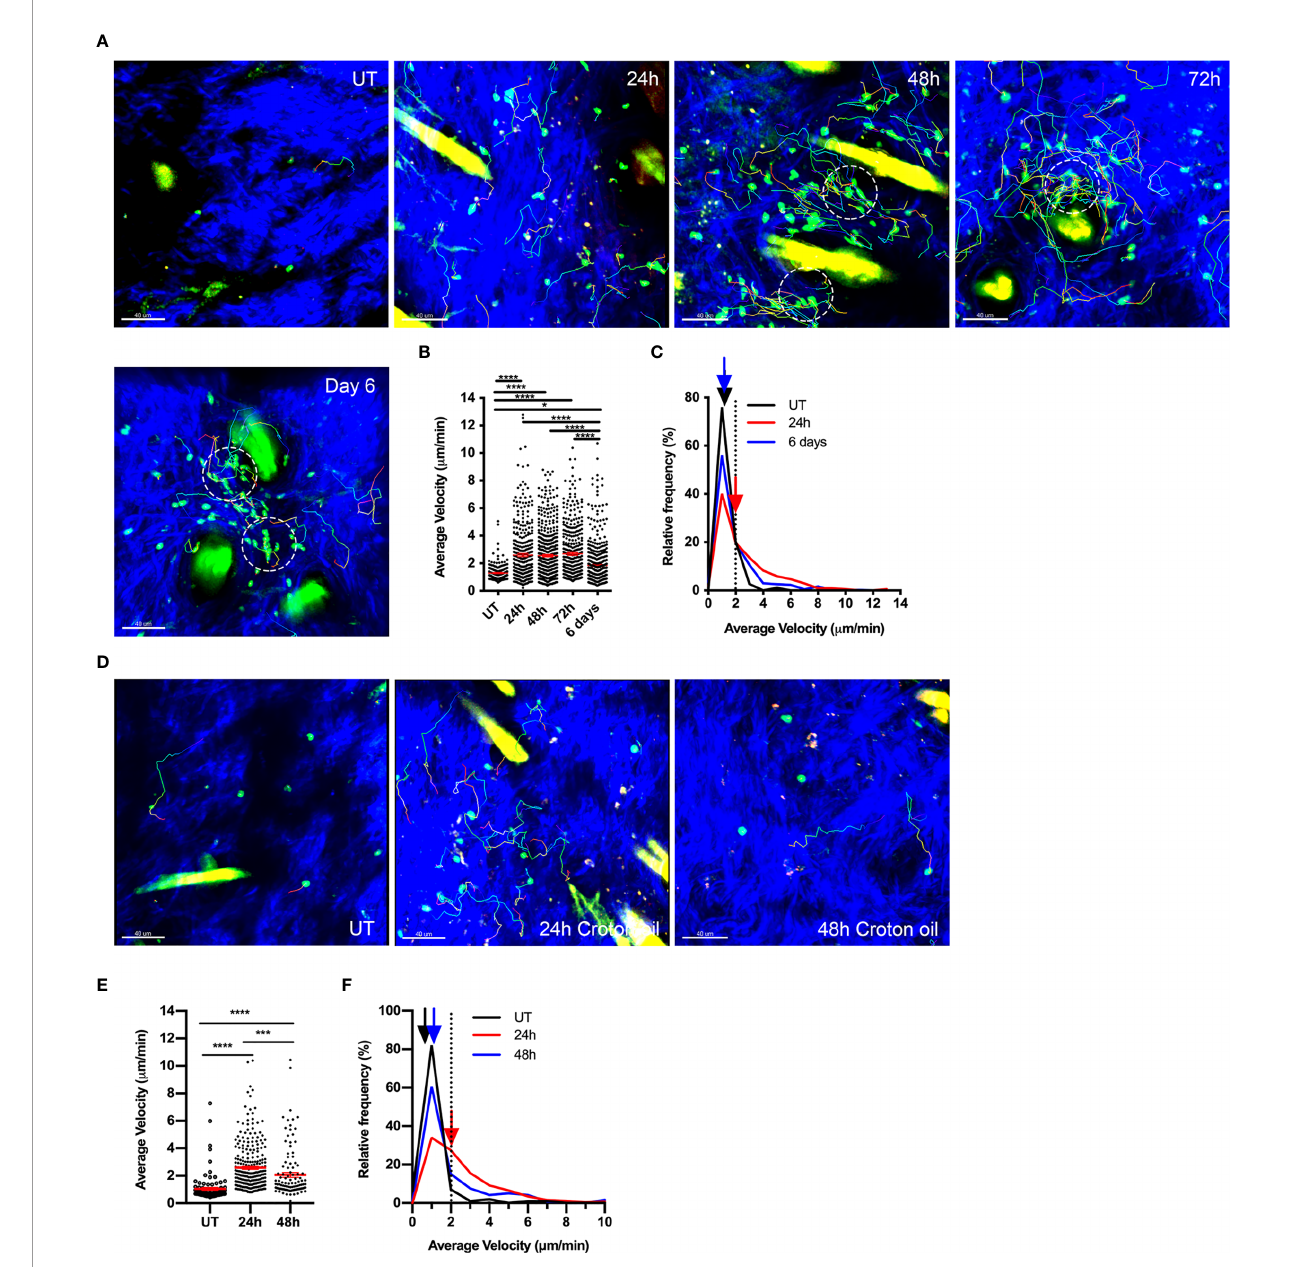
FIGURE 1 | Tregs increase migration around hair follicles in response to both adaptive and innate stimuli. (A – C) Effects of CS response on Treg migration. Treg motility in the fl ank skin was examined in Foxp3-GFP mice using MP-IVM in either untreated (UT) skin, or over a time course of CS-induced in fl ammation. (A) MP- IVM images of the dermis of Foxp3-GFP mice showing the paths of migration (multicoloured) of GFP + Tregs (green) in UT mice, and CS mice 24, 48, 72 h and 6 days after challenge. Scale bars - 40 µm. Collagen fi bres (blue) are visualized by secondary harmonic signal (SHG). Dotted circles denote intradermal clusters of Tregs. (B) Alterations in Treg migration velocity over a time course of CS. Data show velocities for individual Tregs as well as group mean ± sem. (C) Relative frequency distribution of the average velocity of individual Tregs from UT, 24 h or 6 days post CS challenge. Arrows indicate the median velocity, and the dotted line indicates the 2 µm/min motility threshold. (D – F) Treg migratory response in innate skin in fl ammation induced by Croton oil (CO). (D) MP-IVM images of intradermal Treg migration paths in Foxp3-GFP mice undergoing CO-induced in fl ammation, showing example images from untreated skin (UT), and 24 & 48 h post CO application. Scale bars - 40 µm (E) Alterations in Treg migration velocity during CO-induced in fl ammation. Data show velocities for individual Tregs as well as group mean ± sem. (F) Relative frequency distribution of the average velocity of individual Tregs from UT, 24 or 48 h CO-treated mice. Arrows indicate the median velocity, and the dotted line indicates the 2 µm/min motility threshold. All data are shown as mean ± SEM from 3-6 mice/group. Data were analysed using a Kruskal-Wallis test with Dunn ’ s multiple comparison tests between all timepoints. * p < 0.05, *** p < 0.001, **** p < 0.0001 for comparisons